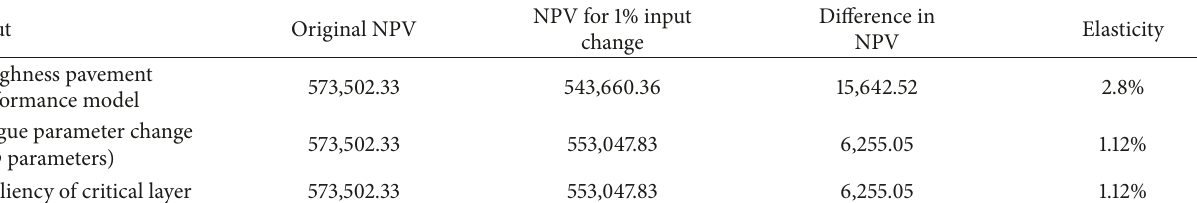
Table 9: Elasticity analysis.